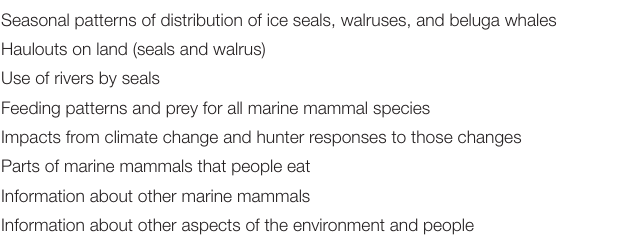
TABLE 2 | Example of the list of topics the researchers sought to address in the interviews. This list is from the interviews in Hooper Bay in January 2017. Seasonal patterns of distribution of ice seals, walruses, and beluga whales Haulouts on land (seals and